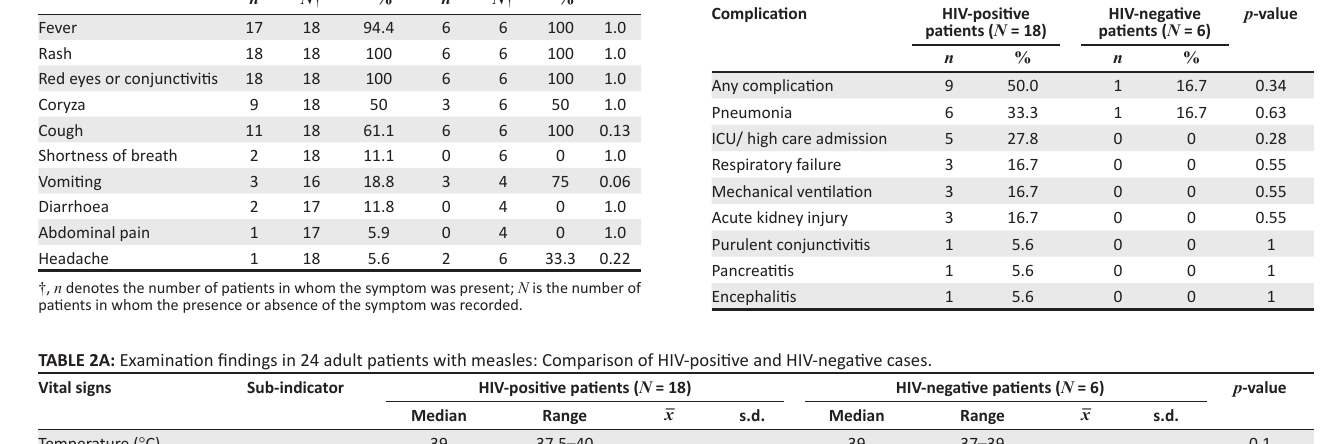
TABLE 4: Complications in 24 adult patients with measles: Comparison of HIV-positive and HIV-negative cases.